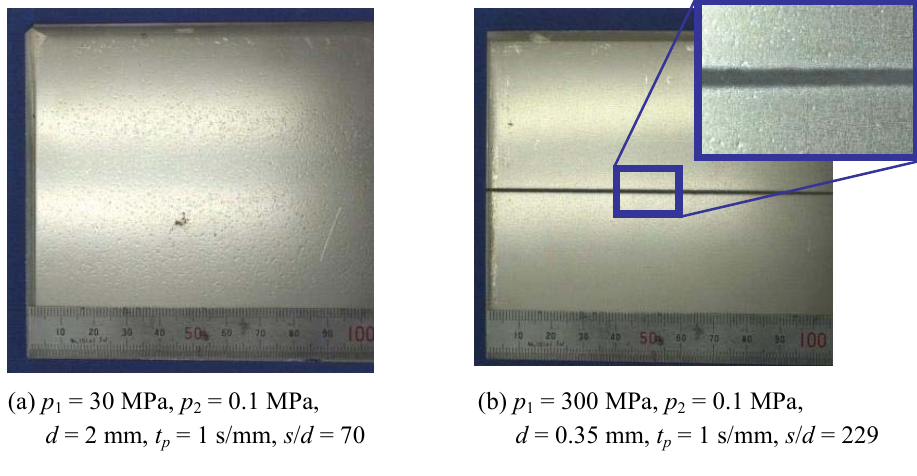
Fig. 12 Features of peened surfaces (JIS